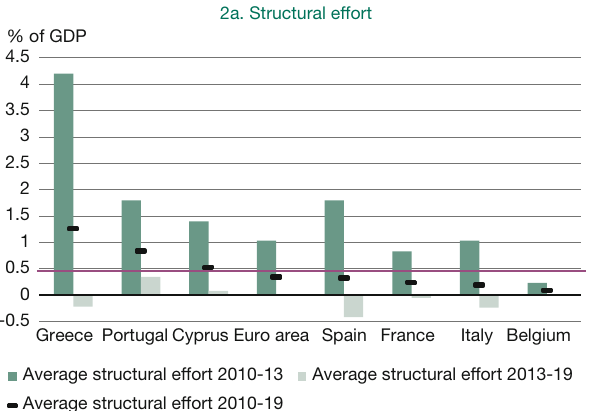
Structural adjustment, interest payments and public investment in selected euro area countries